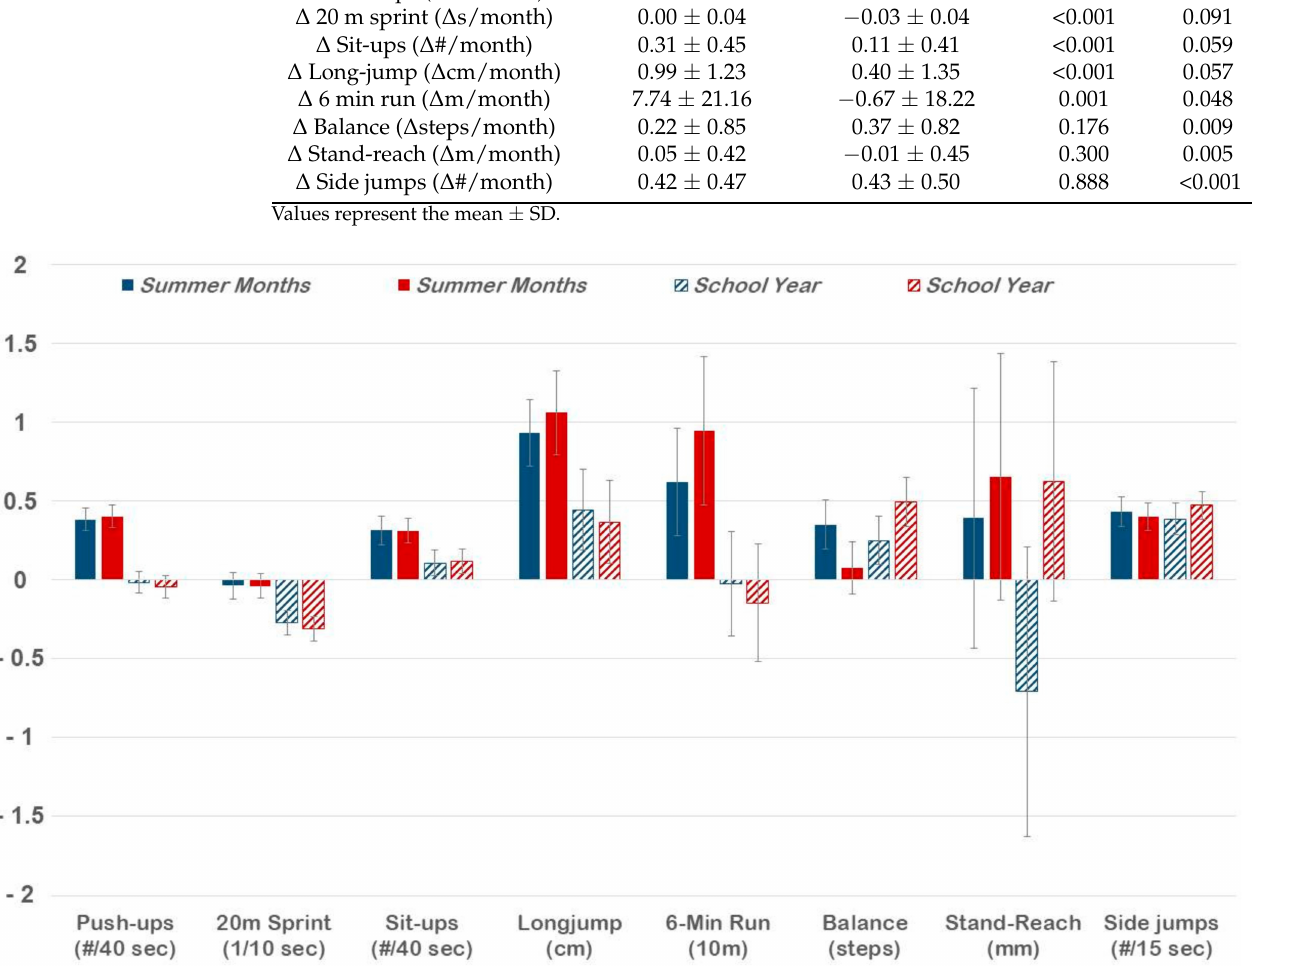
Figure 1. Changes in physical fitness during the school year and the summer months, separately for boys and girls. The values represent the mean change per month with a 95% confidence